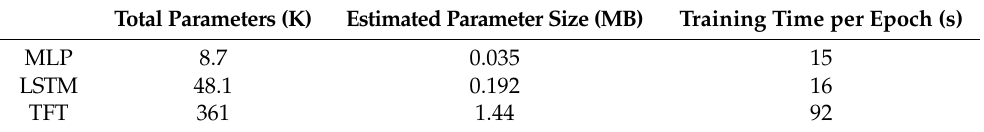
Table 6. Variables related to neural networks Table 6 . Variables related to neural networks complexity.